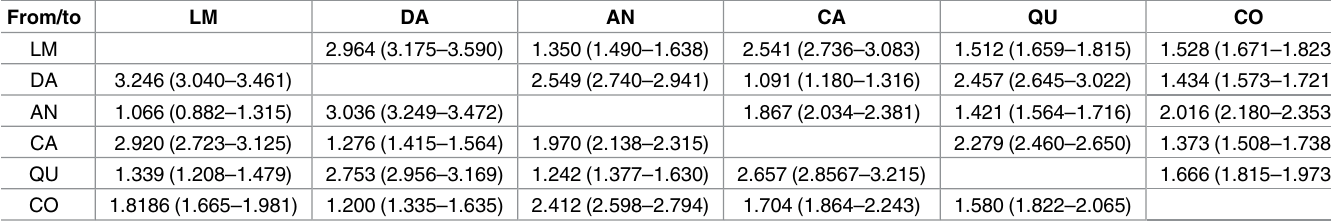
Table 3. Number of migrants per generation (with 95% CI) of Metacarcinus edwardsii by sampling site.